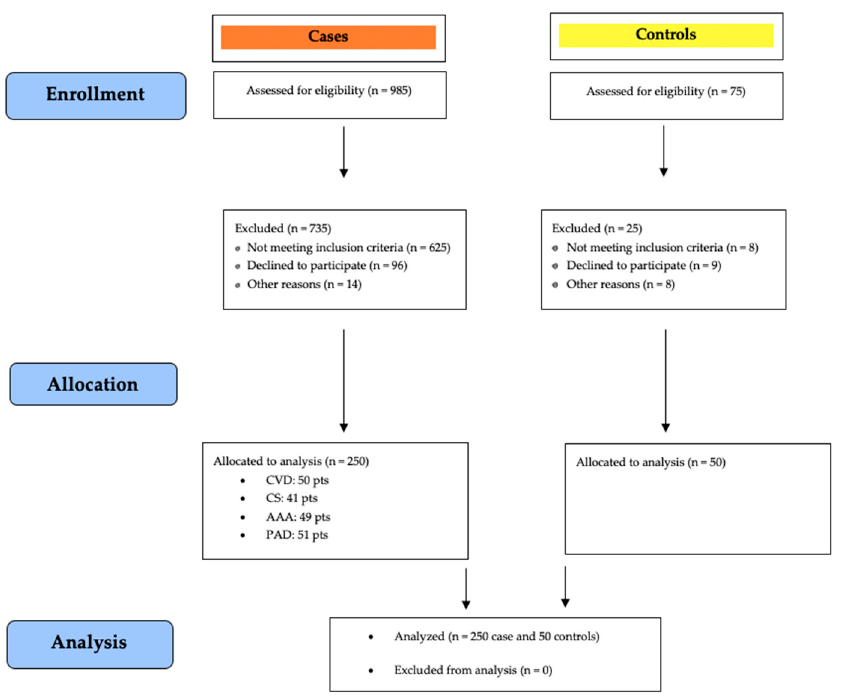
Figure 1. Flow chart for the inclusion of study subjects. (CVD = chronic venous disease; CS = carotid stenosis; AAA = abdominal aortic aneurysm; PAD = peripheral artery disease).